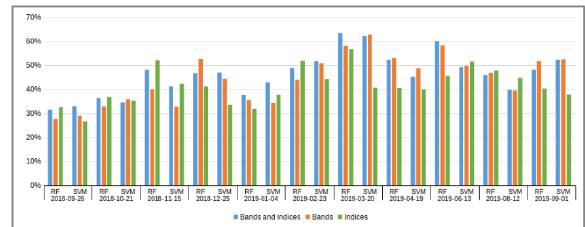
Figure 4. Comparison of GA for each classifier and date used in Scenario 2